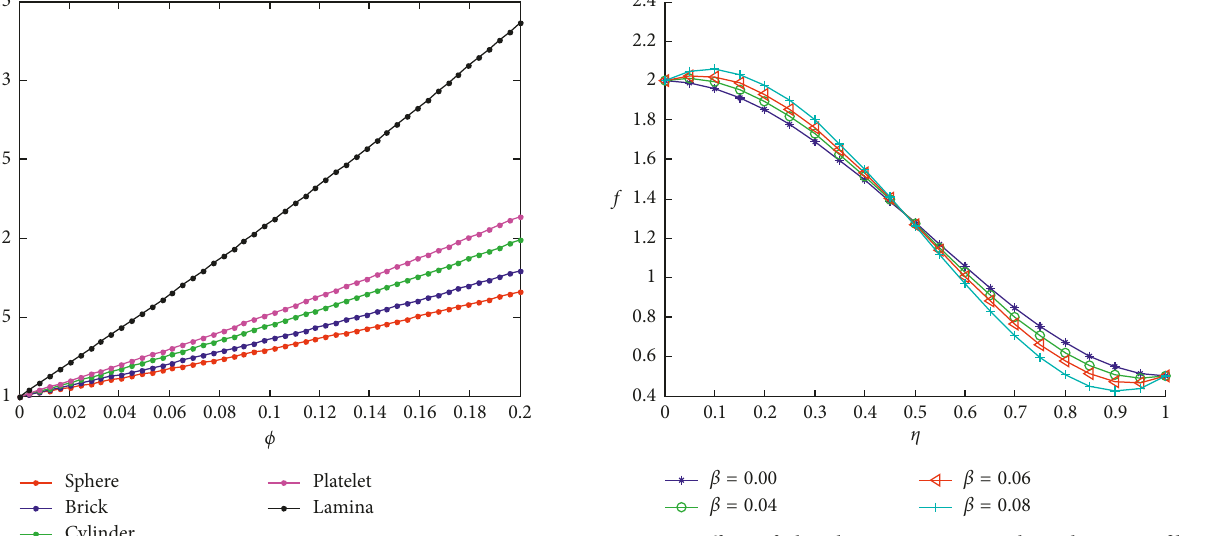
Nb 0 . 2 , c (cid:31) (cid:31)